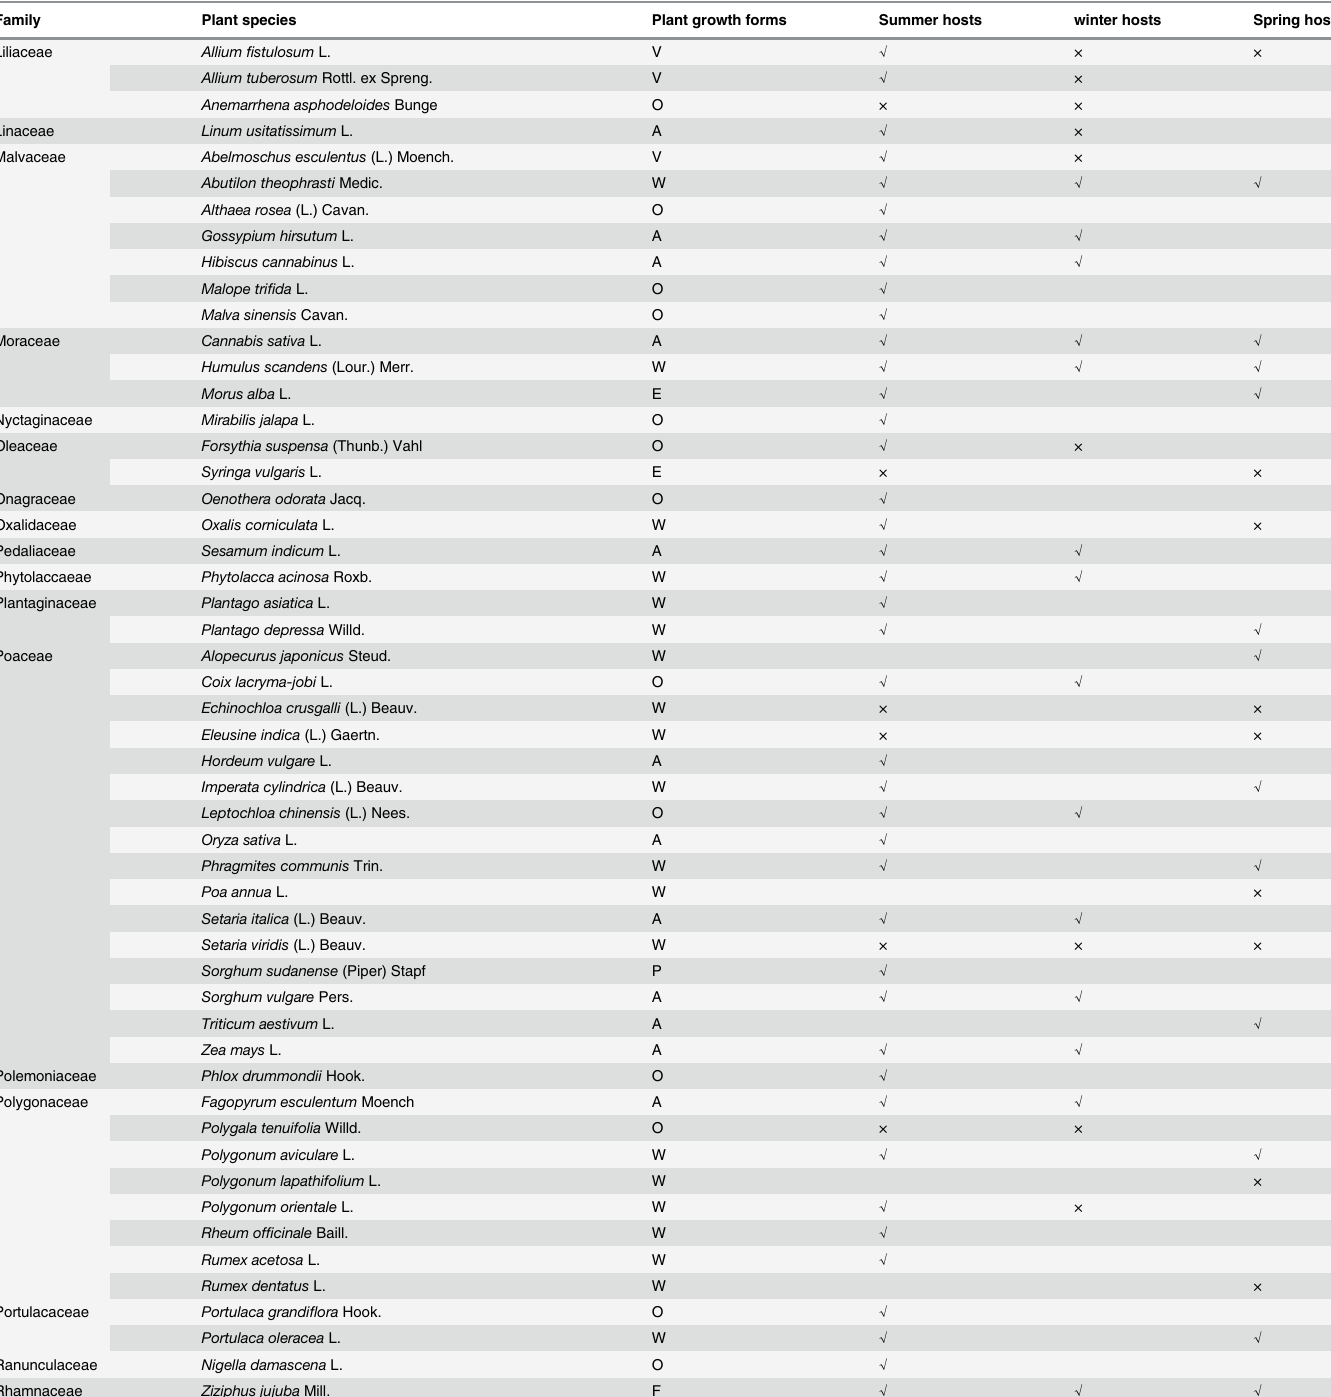
Portulacaceae Portulaca grandi fl ora Hook. O √ Portulaca oleracea L. W √ √ O √ F √ √